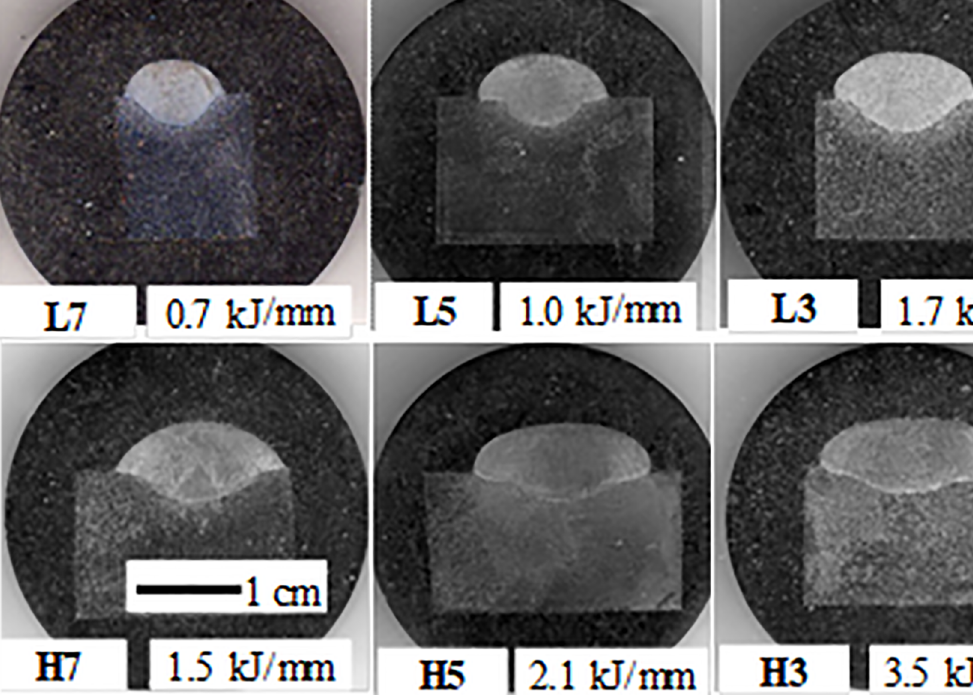
Figure 1. Transverse sections of welded coupons.